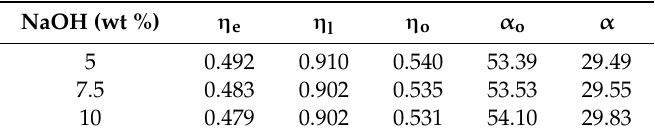
Table 4. Modulus efficiency factor ( η e ), length efficiency factor ( η l ), orientation efficiency factor ( η o ), limit angle ( α o ), mean orientation angle ( α ).